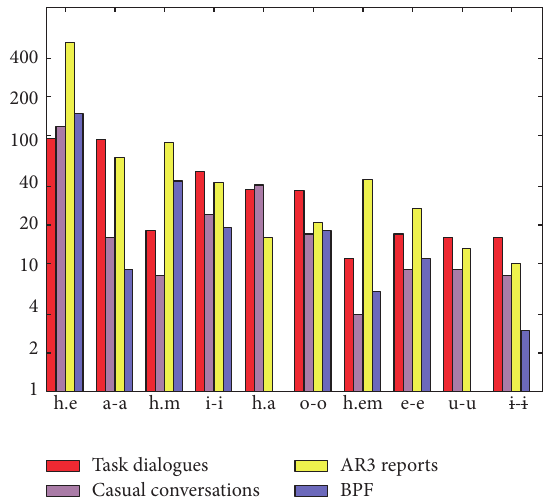
Figure 2: Distribution (in log scale) of the top ten frequent hesitations across the parts of joint corpus, where h.e, h.m, h.a and h.em are filled pauses (of [ J (cid:2) ], [ (cid:3)(cid:2) ], [m (cid:2) ], and [ J (cid:2) m (cid:2) ] types, resp.), and othersarelengtheningsofcertainvowels(/a/,/i/,/o/,/e/,/u/and/ (cid:4) /).